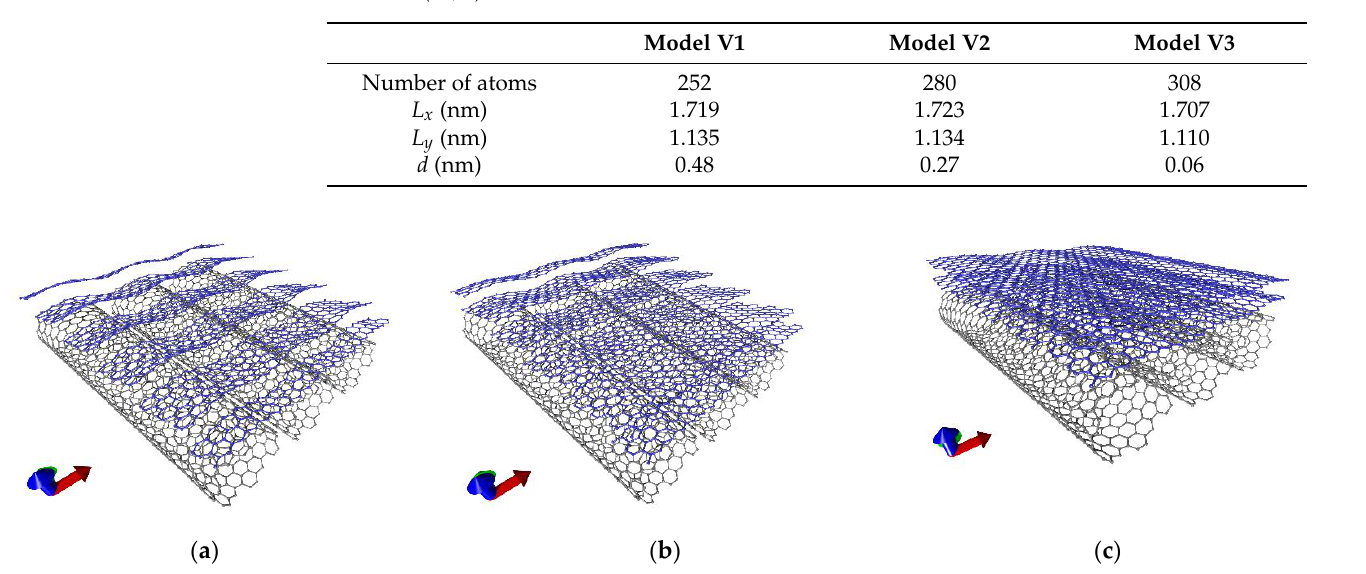
Figure 2. Topological models of extended fragments of hybrid films formed by bilayer graphene and SWCNTs (12,6): ( a ) model V1; ( b ) model V2; ( c ) model V3.